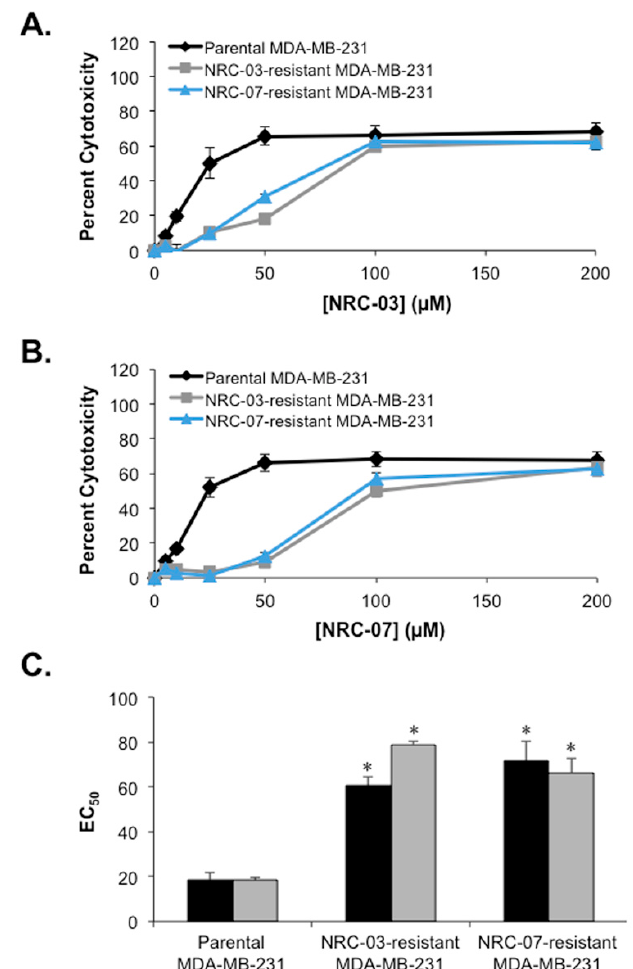
Figure 1. NRC-03-resistant and NRC-07-resistant breast cancer cells are refractory to both NRC-03 and NRC-07 in comparison to parental cells. Parental MDA-MB-231 cells, NRC-03-resistant MDA-MB-231 cells, and NRC-07-resistant MDA-MB-231 cells were cultured in the absence or presence of the indicated concentrations of ( A ) NRC-03 or ( B ) NRC-07 for 24 h. Cell viability was then determined by MTT assay. Data are significant ( p < 0.0001) by ANOVA. ( C ) Cell viability measurements were used to calculate the EC 50 of NRC-03 (black) and NRC-07 (grey). PBS was the vehicle for peptide. Data shown represent the mean of three independent experiments ± SEM and are statistically significant by the Bonferroni multiple comparisons test in comparison to parental MDA-MB-231 cells; * p < 0.01.